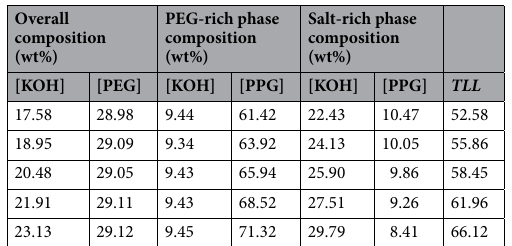
Table 2. Experimental tie-line data of {PEG 600 + KOH + H 2 O} systems at 298.15 K and atmospheric pressure (≈ 85 kPa). The standard uncertainty for weight percent of each component is